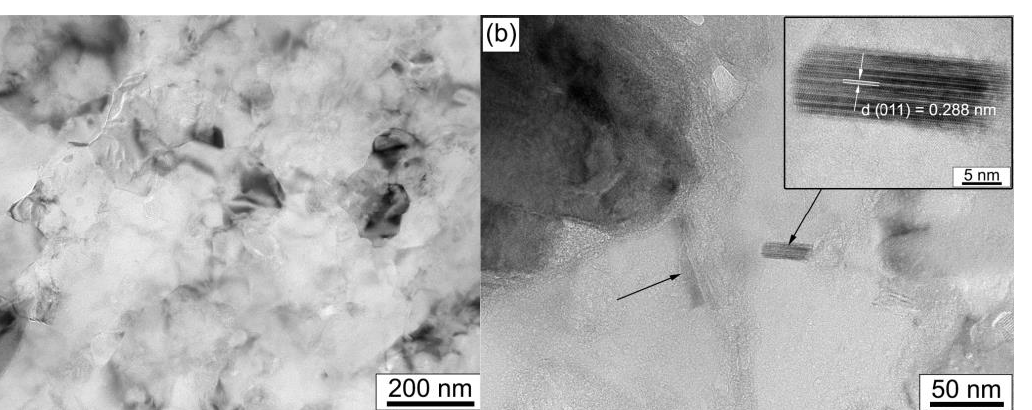
Figure 7. Bright-field TEM images of the hot-pressed sample with addition of 2% stearic acid: ( a ) nanocrystallite structure, and ( b ) lamellar nanoparticles of Al 4 C 3 .